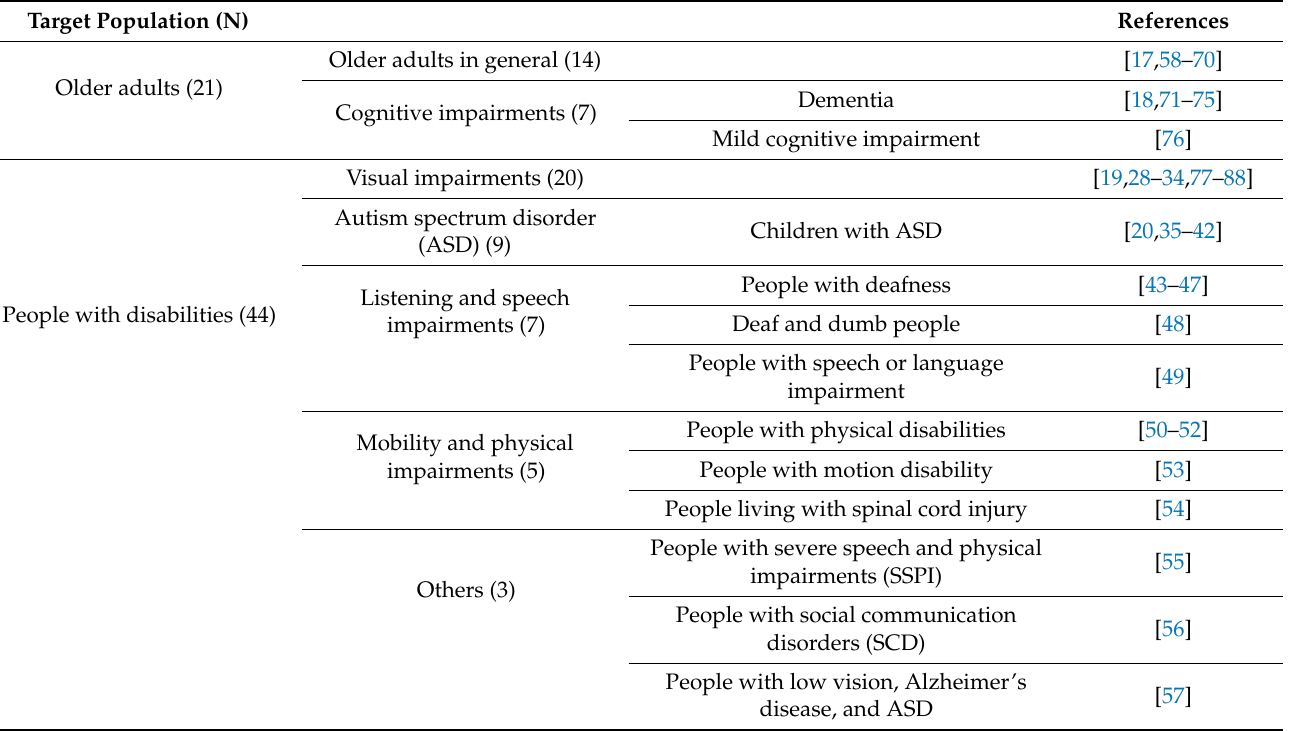
Table 1. Classification of target users.